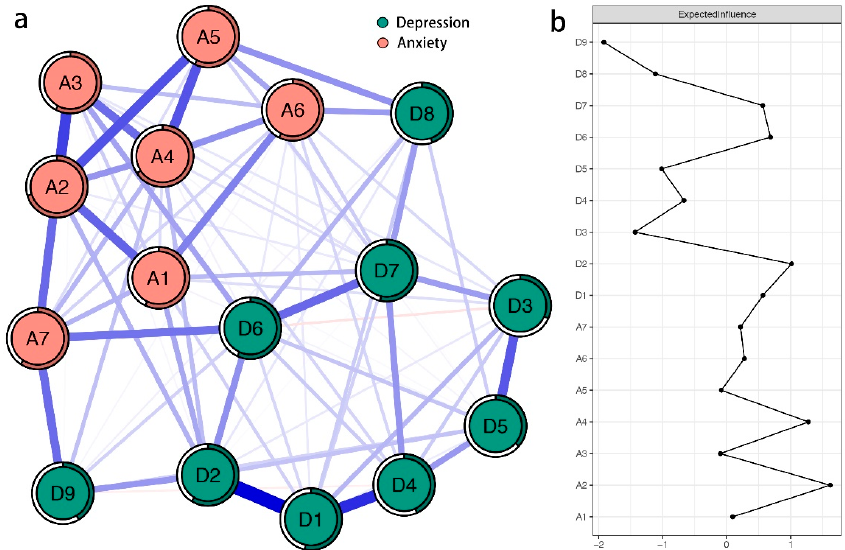
Figure 1. Network structure of depression and anxiety symptoms in tinnitus sufferers. ( a ) Blue edges represent positive correlations, red edges represent negative correlations, and the thickness of the edge reflects the magnitude of the correlation. The circles around nodes depict their predictability. ( b ) Centrality plot depicting the expected influence of each symptom in the network (z-score). D1 = Anhedonia; D2 = Feeling depressed or hopeless; D3 = Sleep problems; D4 = Energy loss; D5 = Appetite changes; D6 = Feeling of worthlessness; D7 = Trouble concentrating; D8 = Psychomotor issues; D9 = Suicidal ideation; A1 = Feeling nervous or anxious; A2 = Unable to control worry; A3 = Excessive worry; A4 = Relaxation difficulty; A5 = Too restless to sit still; A6 = Easily annoyed or irritable; A7 = Afraid something awful might happen.